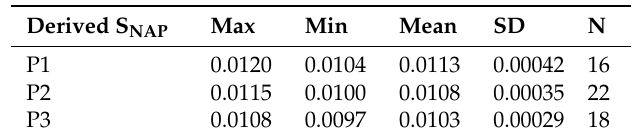
Table 5. Non-algal particle absorption spectral slopes S NAP at Stations P1, P2 and P3. “Max.”, “Min.”, and “SD” stand for maximum, minimum, and standard deviation, respectively, and “N” is the number of